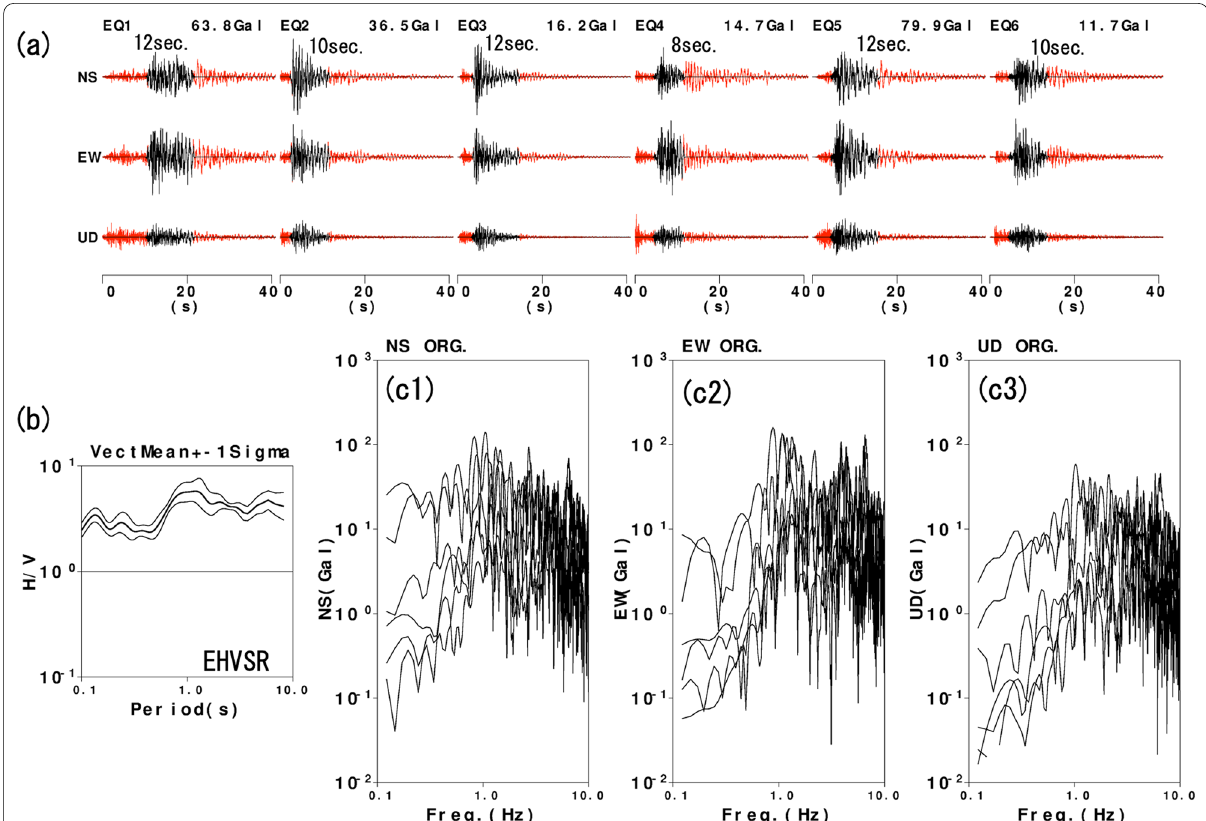
Fig. 2 Process to evaluate EHVSR at TTR002 site. a Three component acceleration waveforms of used records with PGAs and window lengths of analysis. Red color shows the full waves and black shows the windowed waveforms. b Average and the panel c1 – c3 . c1 – c3 show three component Fourier spectra of the target records that are used to evaluate